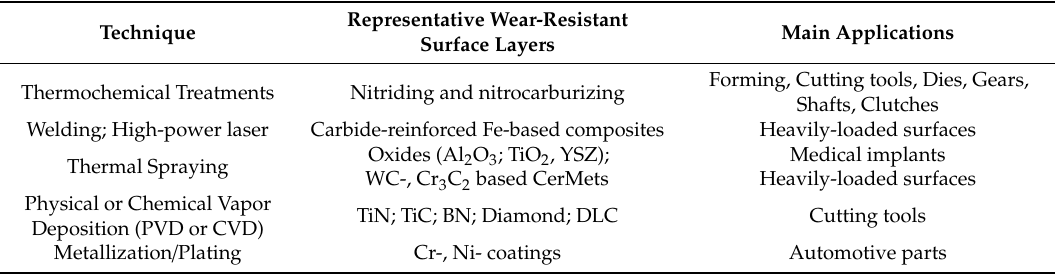
Table 2. Main categories of coatings techniques and representative